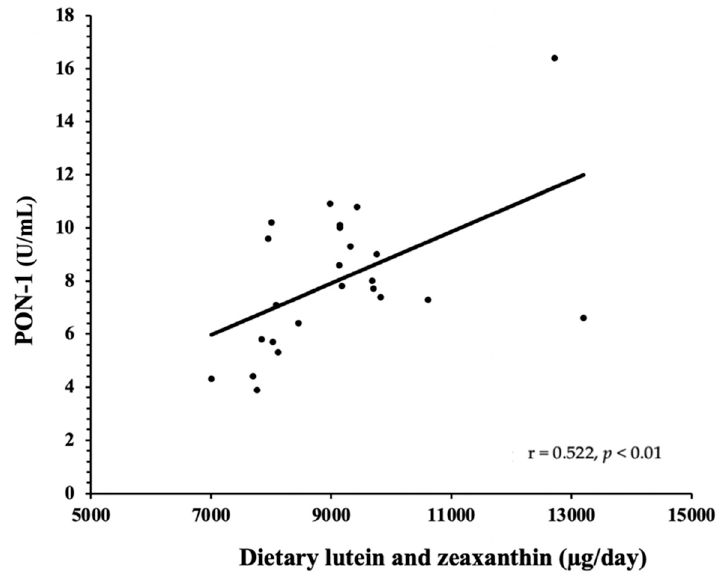
Figure 2. Dietary lutein and zeaxanthin correlated with PON-1, (r = 0.522, p < 0.01).